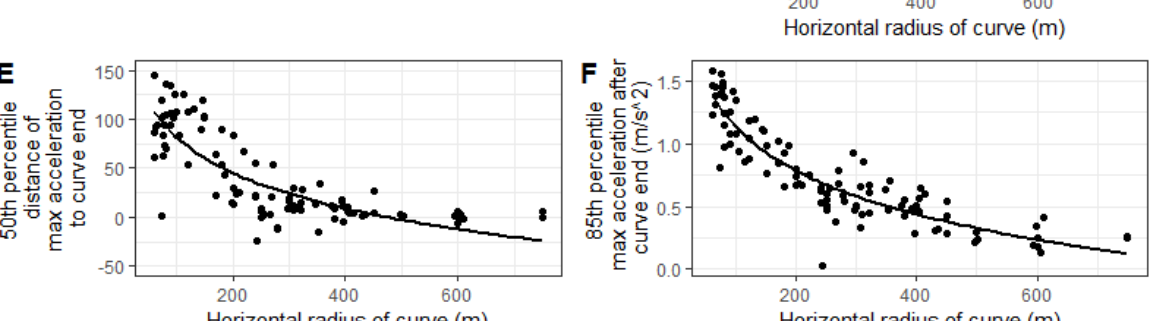
Figure 9. Scatterplots comparing horizontal radius to the 85 th percentile of acceleration and deceleration as well as the positions of maximum acceleration and deceleration Breakpoints are defined based on the acceleration being 0 m/s 2 at those positions (Figure 3), so pos50 (50 th percentile of those positions) for each breakpoint can be used as a position in an acceleration profile where 0 m/s 2 is observed. By adding information from the regression lines in Figure 8, a deceleration and acceleration profile can be plotted based on the positions of the breakpoints, maximum acceleration, curve start and curve end. Figure 10 shows these acceleration profiles for the same set of horizontal radii used in Figure 6. Figure 10A shows the deceleration profiles upon curve entry based on the following coordinates: ( pos50 BP1 , 0), ( pos50 MAXdec , a85 MAXdec ), (0, a85 CS ), ( pos50 BP2 , 0). Figure 10B shows the acceleration profiles upon curve exit based on the following coordinates: ( pos50 BP3 , 0), ( pos50 MAXacc , a85 MAXacc ), (0, a85 CE ), ( pos50 BP4 , 0). Overall, Figure 10 shows the deceleration and acceleration development upstream and downstream of a